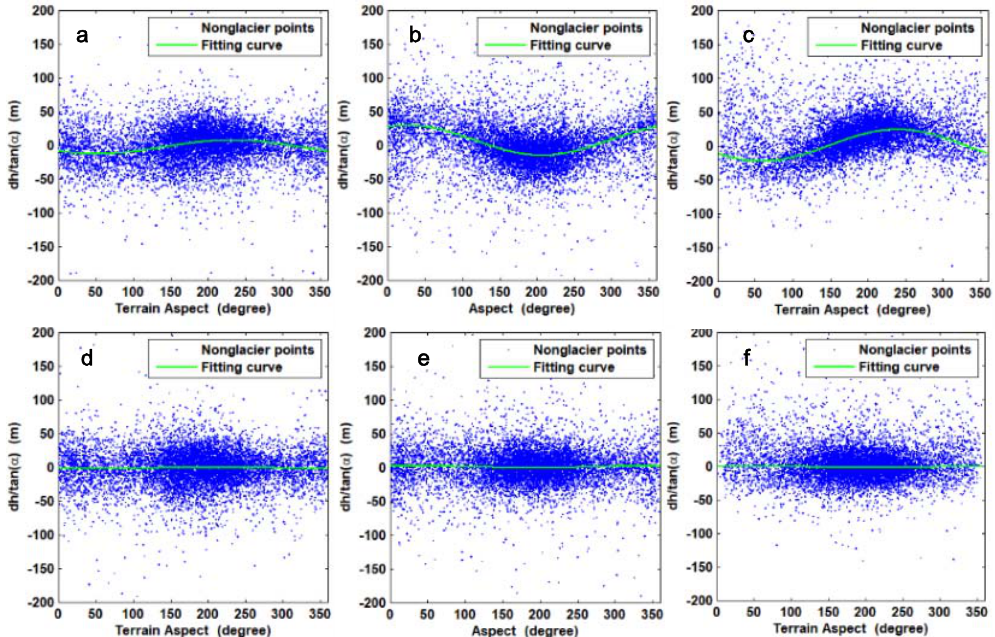
Figure 2. Scatterplots of slope standardized elevation di ff erences versus aspect and fitting curve